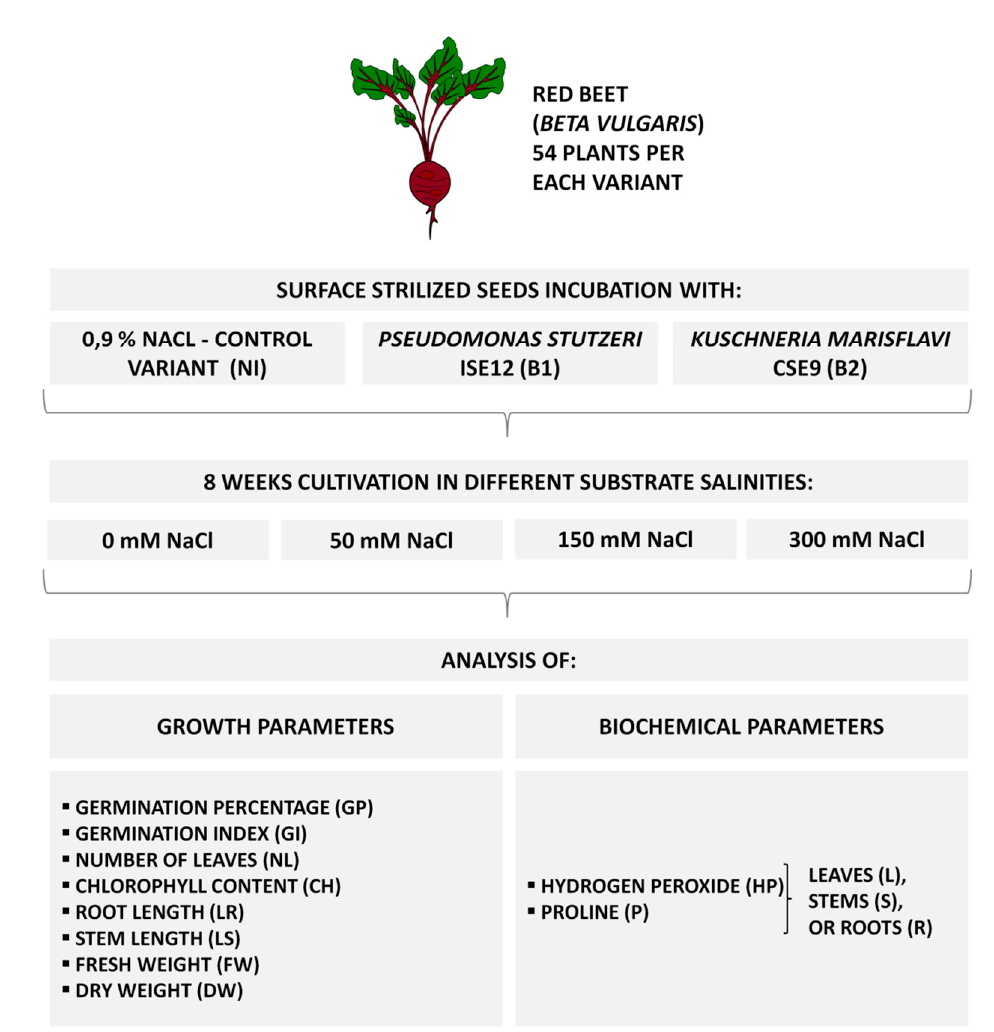
Figure 1. Experimental design.